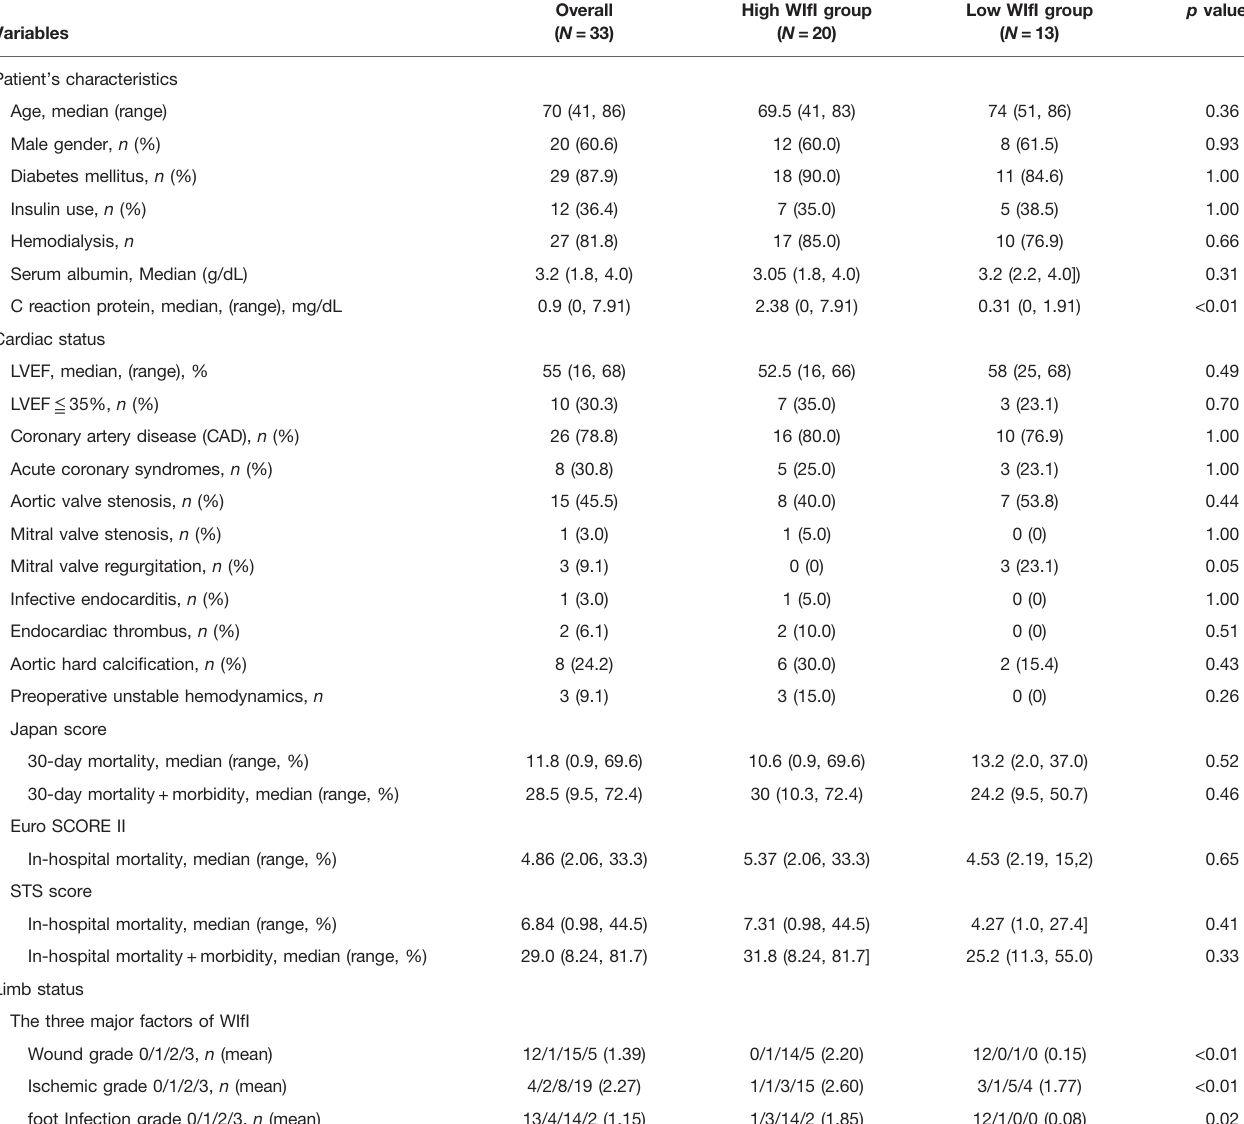
TABLE 1 | Comparison on baseline characteristics and cardiac/limb states between two